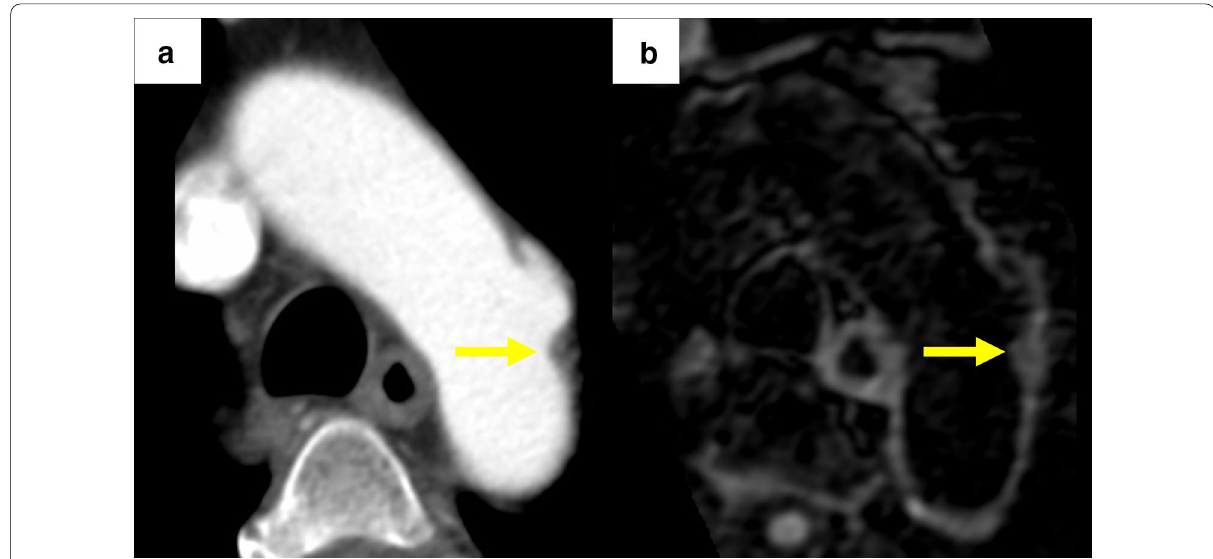
Fig. 2 There is a small saccular aortic aneurysm on the distal arch with the atheromatic plaque. The saccular aneurysm was approximately 35 mm in diameter and the atheromatic plaque thickness was approximately 4 mm. a Computed tomography angiogram images and b magnetic resonance